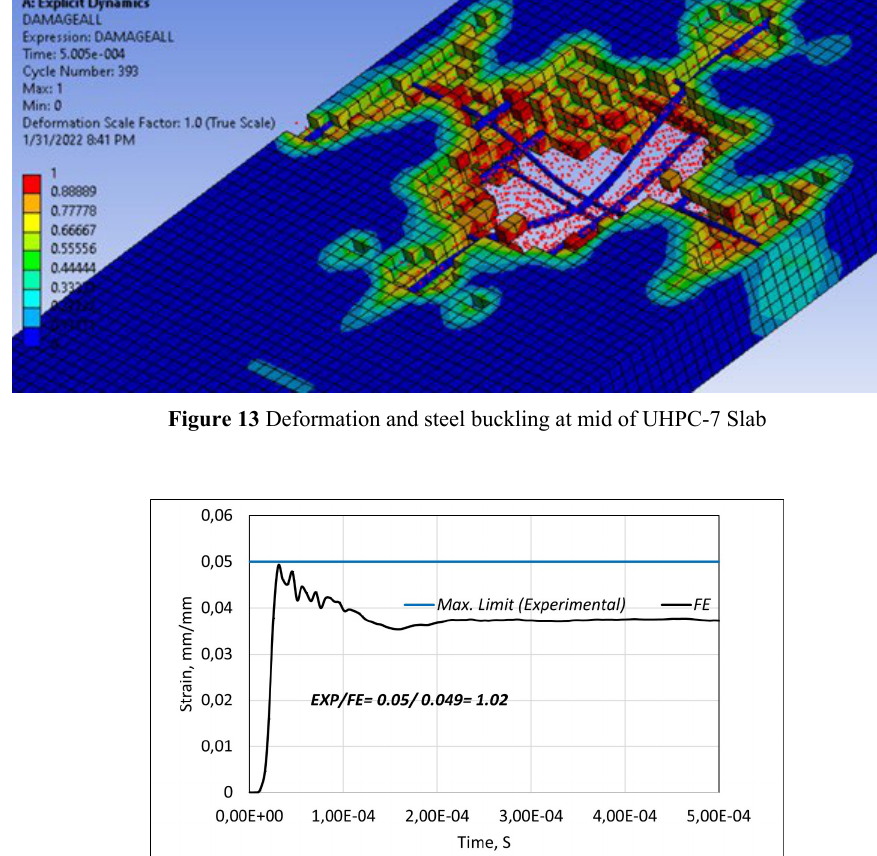
Figure 14- Comparison between experimental & FE results of steel strain detected by strain gauge at the center (Point 1) of UHPC-7